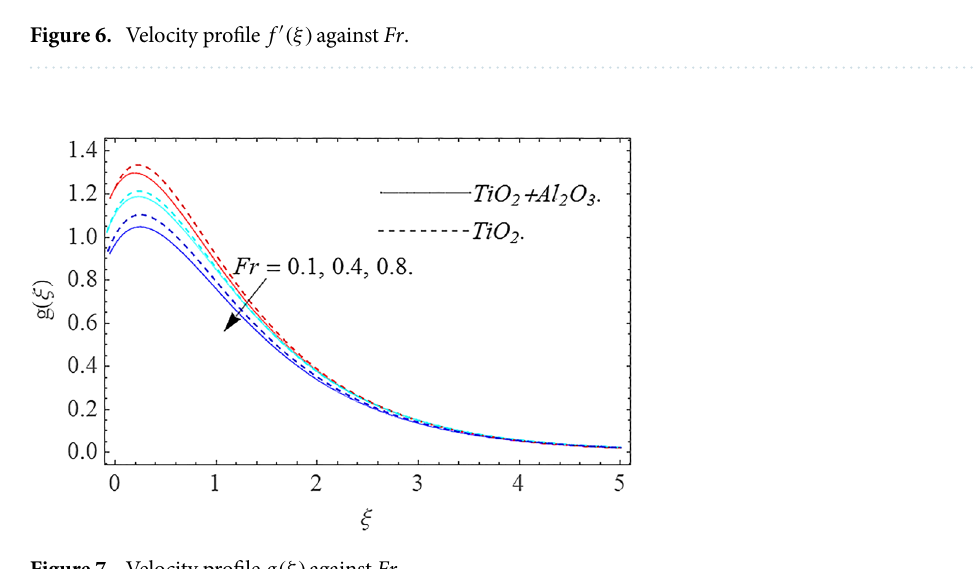
Figure 7. Velocity profile g (ξ) against Fr